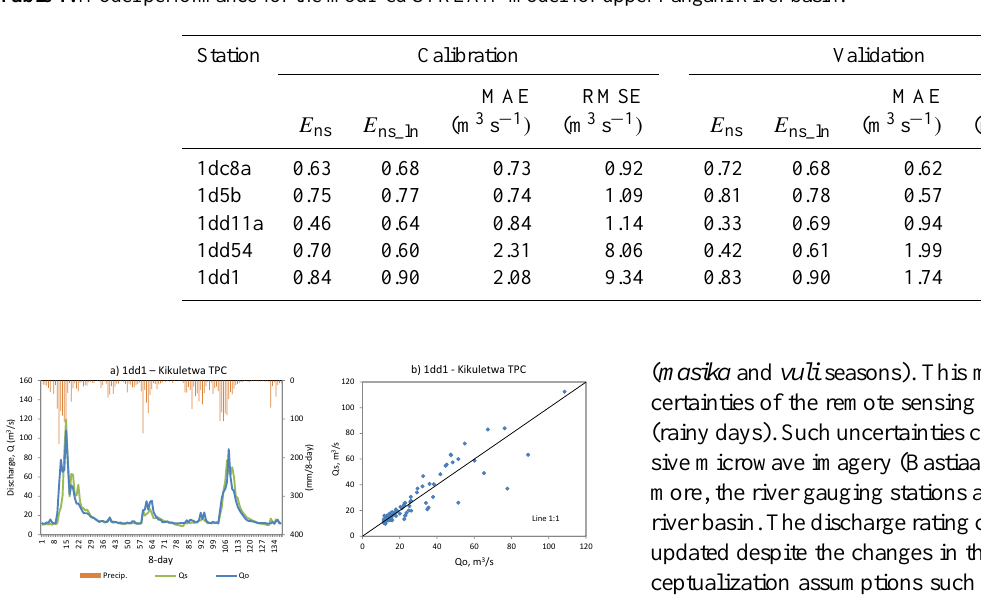
Figure 6. (a) Comparison of observed ( Q o ) and simulated dis- charge ( Q s ) and precipitation for calibration period 2008 (8-day pe- riods 1–46) and validation 2009 and 2010 (8-day periods 47–138) in the upper Pangani River basin; (b) the corresponding scatter plot of Q o and Q s for the most downstream gauge